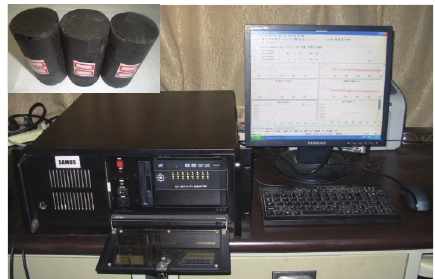
Figure 1: Coal samples and acoustic emission system.